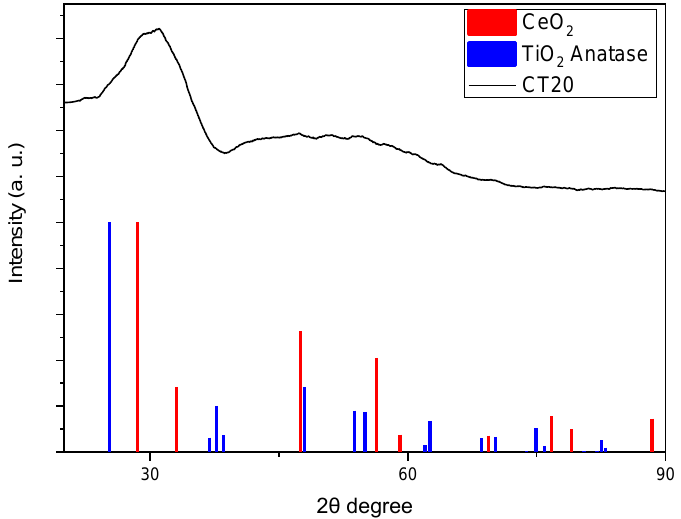
Figure 3. XRD Pattern of CT20. Blue and red lines show the cerianite-, cubic fluorite- and anatase-